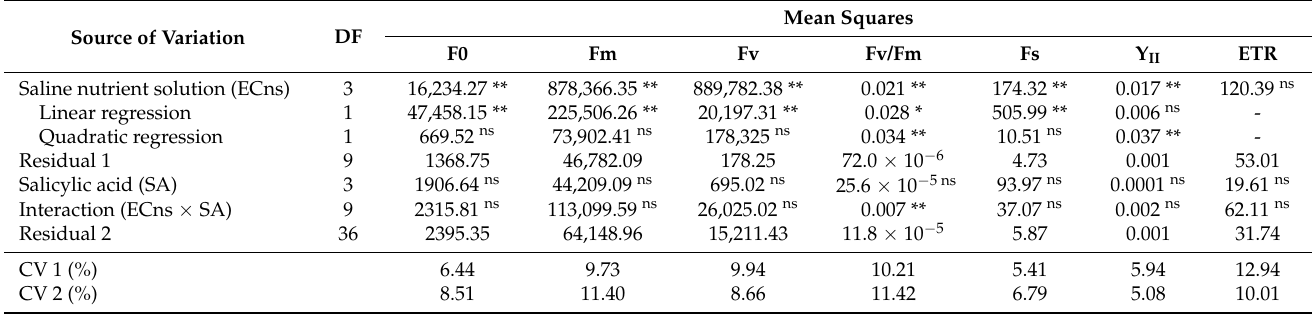
Table 4. Summary of the analysis of variance (ANOVA) for initial fluorescence (F0), maximum fluorescence (Fm), variable fluorescence (Fv), quantum efficiency of photosystem II (Fv/Fm), initial fluorescence before saturation pulse (Fs), quantum efficiency of photosystem II in the light phase (Y II ), and electron transport rate (ETR) of Japanese cucumber grown in a hydroponic system with saline nutrient solution and foliar application of salicylic acid, 40 days after